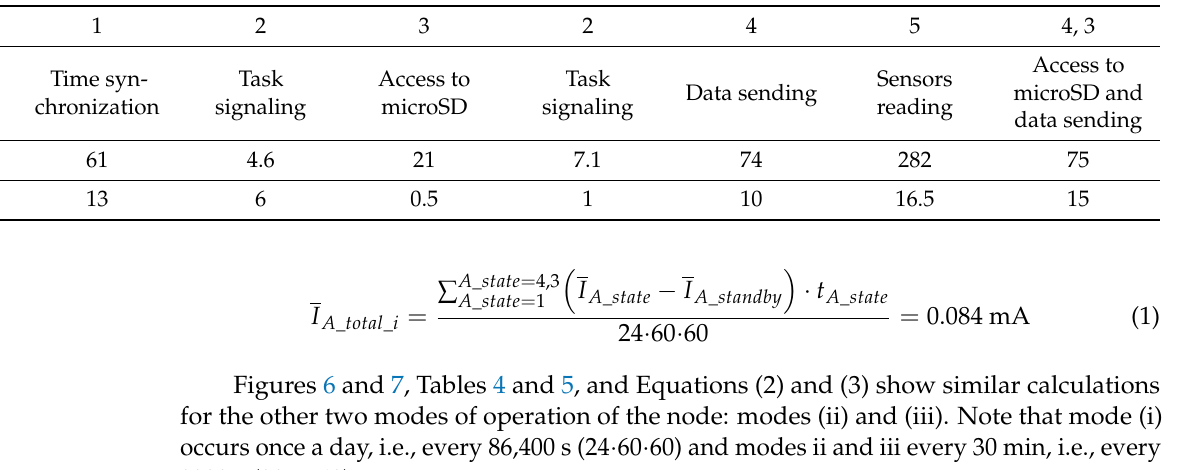
Table 3. Description of functional states of node A—mode (i).